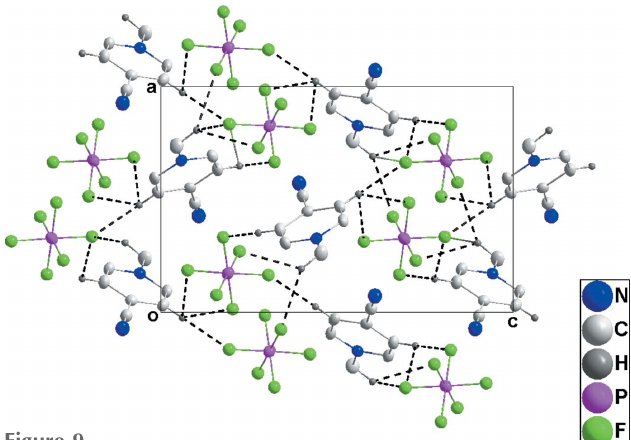
Figure 9 Packing of 3 viewed along the b -axis direction. C—H (cid:2)(cid:2)(cid:2) F hydrogen bonds are shown by black dashed lines.